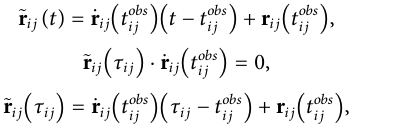
FIGURE 7 Probability distribution of the direction of the observation